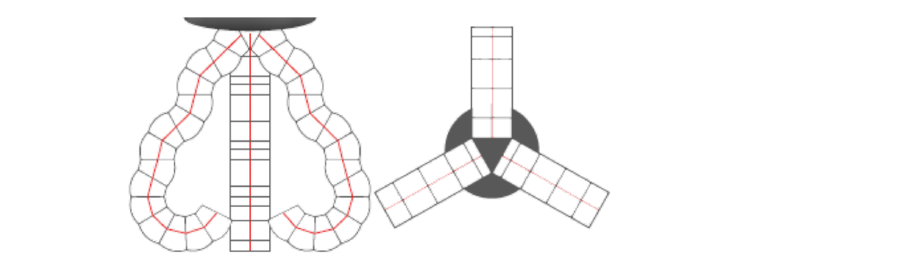
Figure 12. A 3D gripper resulting from the radial assembly of three 2D gripper actuators.